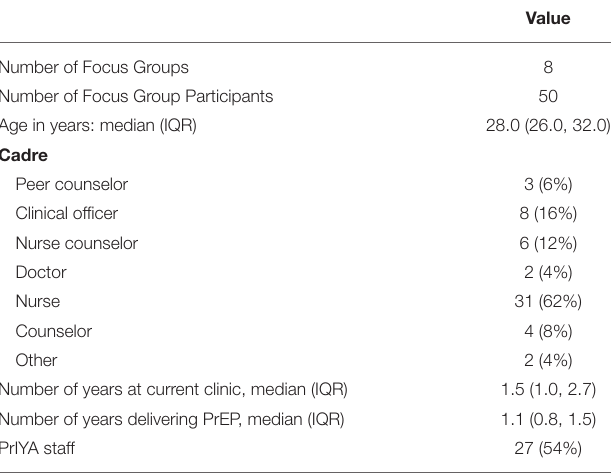
TABLE 2 | PrIYA focus group